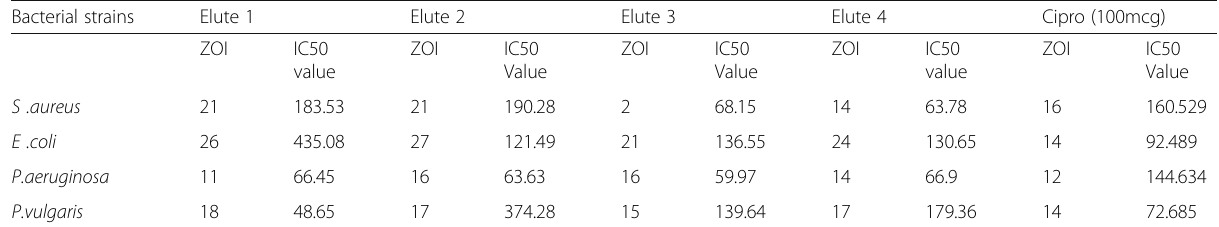
Table 4 Antibacterial activity of ion exchange chromatography elutes from Cucumis sativus seeds, Diameter of zone of inhibition [mm] and IC50 values[mcg/ml] Bacterial strains